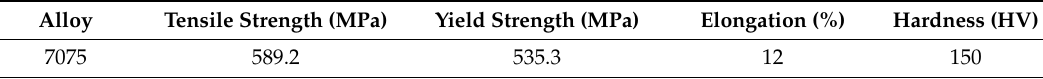
Table 2. Mechanical properties of 7075 aluminum